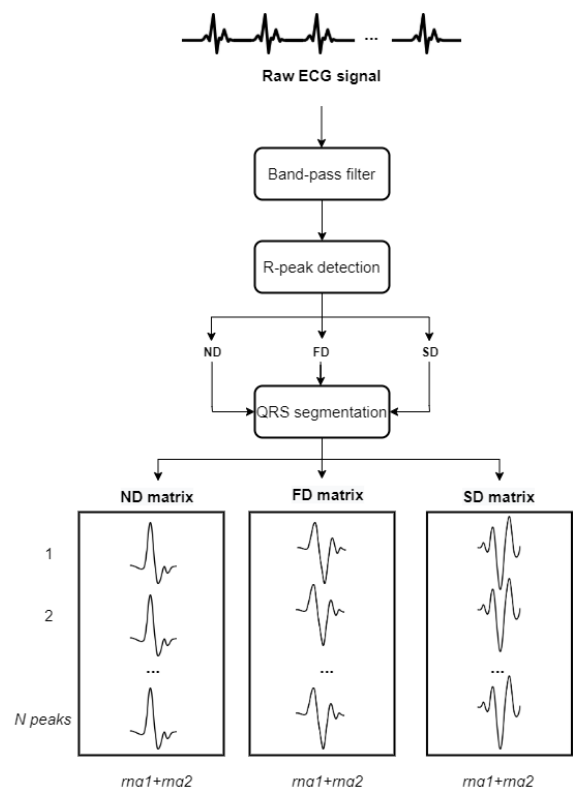
Figure 2. Scheme for signal pre-processing and data segmentation. Variable rng 1 represents the data points on the left of the R peak and rng 2 the data points after, including the R peak. Npeaks refers to the number of selected R peaks in the matrix.